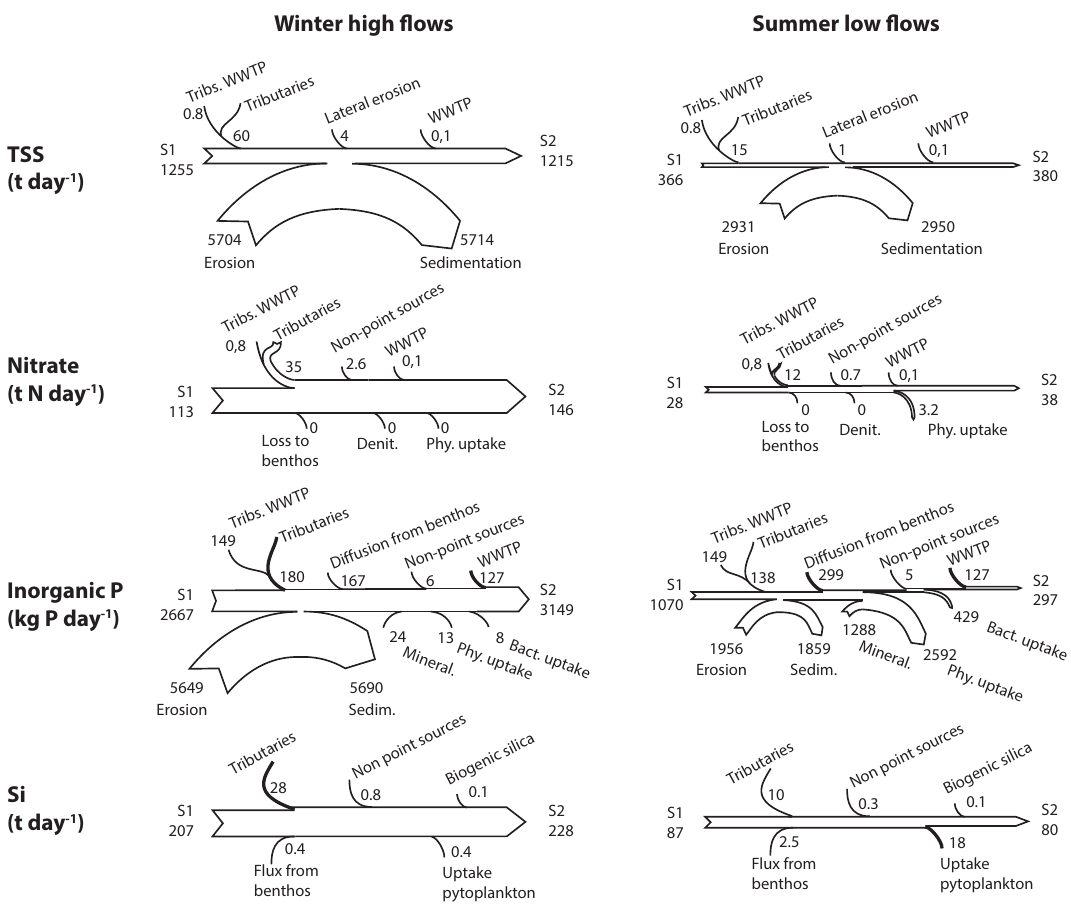
Figure 7. Average winter and summer budgets between S1 and S2 for TSS, nitrate, inorganic P and dissolved silica. All arrow widths are proportional to calculated fluxes, allowing the visual comparison between winter and summer